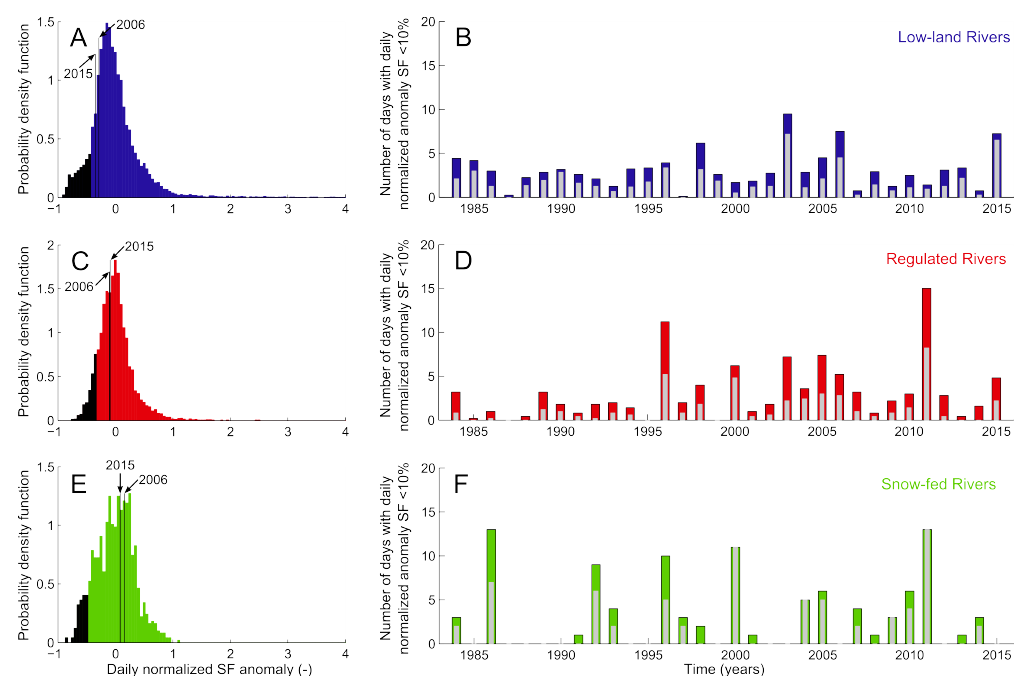
Figure 5. Distributions of daily anomalies in normalized streamflow for low-land ( A ), regulated ( C ) and snow-fed ( E ) rivers during July. Shaded areas show the bottom 10th percentile in the distribution and arrows indicate the averaged anomalies for the heatwaves in 2006 and 2015. The number of days below 10% is shown in the right column ( B , D , F ) for the period 1984–2015, with inset bars indicating the number of consecutive